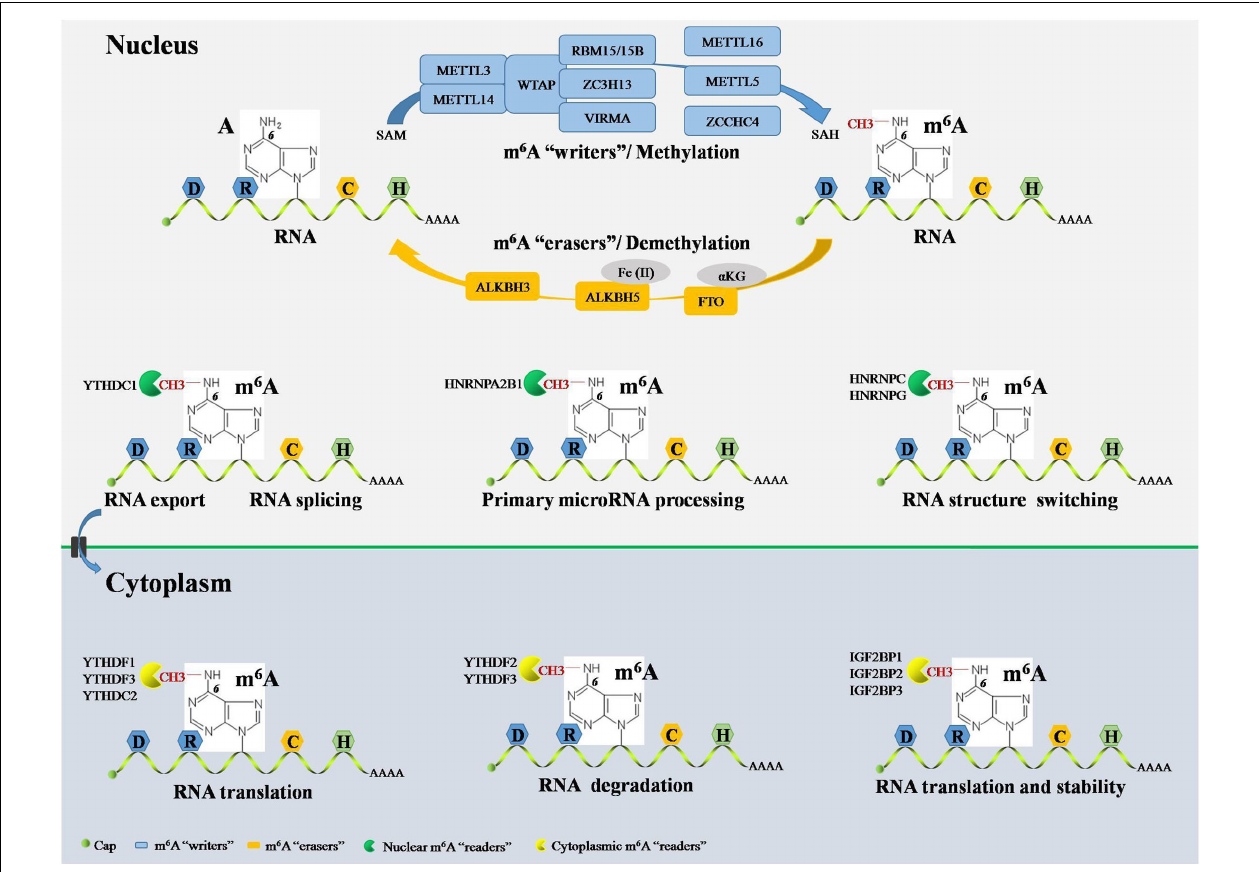
FIGURE 2 | Overview RNA m 6 A modification by its “writers,” “erasers,” and “readers.” The RNA m 6 A have a consensus sequence DRACH sites and methylated A at the N 6 position. In nucleus, m 6 A methylation in RNA can be installed by m 6 A writers complex, including METTL3, METTL14, WTAP, RBM15, RBM15B, and ZC3H13. RNA m 6 A methylation also can be installed by several writers independently, including METTL16, METTL5, and ZCCHC4. The initiate of RNA m 6 A modification is dependent on methyl donor SAM and terminate in SAH production. The RNA m 6 A can be reversibly and dynamically removed by m 6 A erasers in nucleus composed of FTO, ALKBH5, and ALKBH3. FTO-mediated RNA m 6 A demethylation is α KG dependent, and ALKBH5-mediated RNA m 6 A demethylation is Fe(II) dependent. The RNA m 6 A can be recognized by m 6 A readers both in the nucleus and cytoplasm. Cytoplasmic m 6 A readers include YTHDF1, YTHDF2, YTHDF3, IGF2BP1, IGF2BP2, IGF2BP3, and YTHDC2. YTHDF1 and YTHDC2 promote RNA translation. YTHDF2 facilitates RNA degradation. YTHDF3 cooperates with YTHDF1 to promote RNA translation and synergy with YTHDF2 to facilitate RNA degradation. IGF2BP1, IGF2BP2, and IGF2BP3 are essential for promoting the stability and translation of RNA. Nuclear m 6 A readers consist of YTHDC1, HNRNPA2B1, HNRNPC, and HNRNPG. YTHDC1 contributes to RNA splicing and RNA export from nucleus to cytoplasm. HNRNPA2B1 causes primary microRNA processing. HNRNPC and HNRNPG RNA end with structure switching. m 6 A, N 6 -methyladenosine; A, adenosine; C, cytidine; METTL, methyltransferase-like; WTAP, Wilms’ tumor 1-associated protein; RBM, RNA-binding motif; ZC3H13, zinc finger CCCH-type containing 13; ZCCHC4, zinc finger CCHC-type containing 4; SAM, S -adenosylmethionine; SAH, S -adenosyl homocysteine; FTO, fat mass